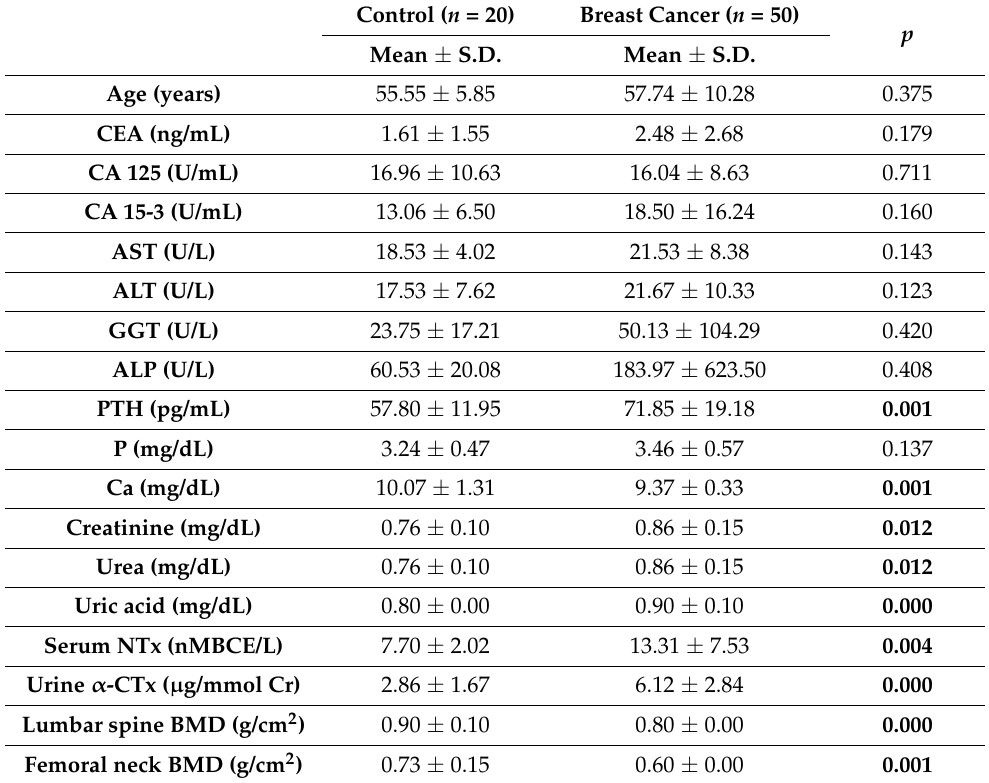
Table 1. Biochemical characteristics of control and breast cancer patients.